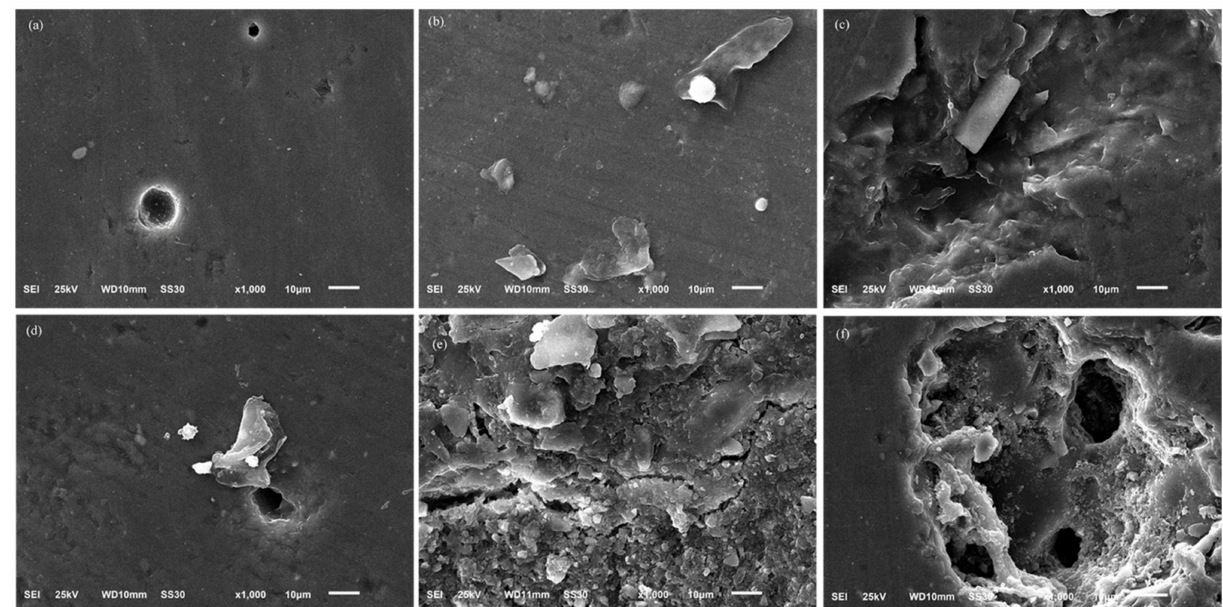
Figure 1. Photomicrographs of commercial dental porcelains incorporated with different concentrations of β -AgVO 3 (Magnification: 1000 × ). ( a ) IPS Inline control. ( b ) IPS Inline incorporated with 2.5% β -AgVO 3 . ( c ) IPS Inline incorporated with 5% of β -AgVO 3 . ( d ) Ex-3 Noritake control. ( e ) Ex-3 Noritake incorporated with 2.5% β -AgVO 3 . ( f ) Ex-3 Noritake incorporated with 5% of β -AgVO 3 . Table 1. Minimum inhibitory concentration (MIC) of pure β -AgVO 3 and antimicrobial activity of dental porcelains incorporated with β -AgVO 3 on metabolic activity and colony-forming units per milliliter (CFU/mL) of microorganisms.